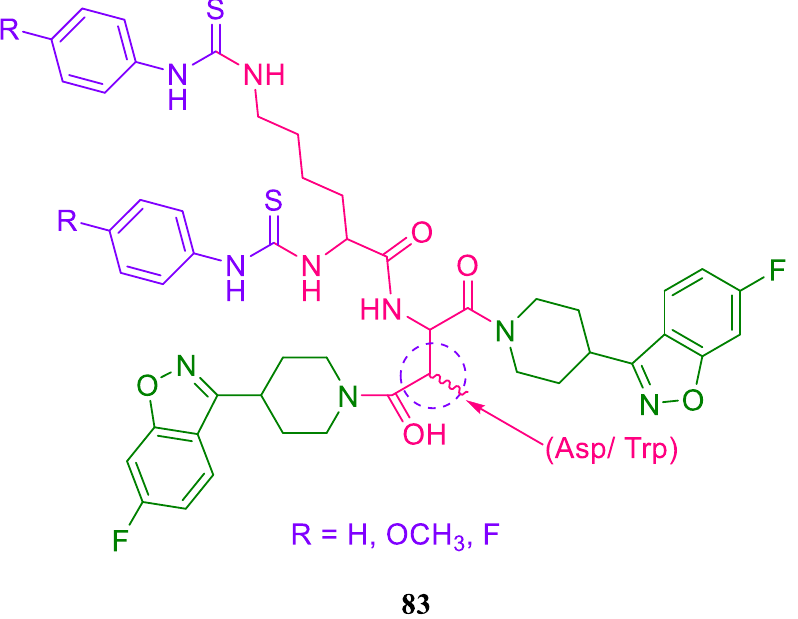
Figure 67. Peptides conjugated to 6-fluoro-3-(piperidin-4-yl) benzo[ d ]isoxazole.